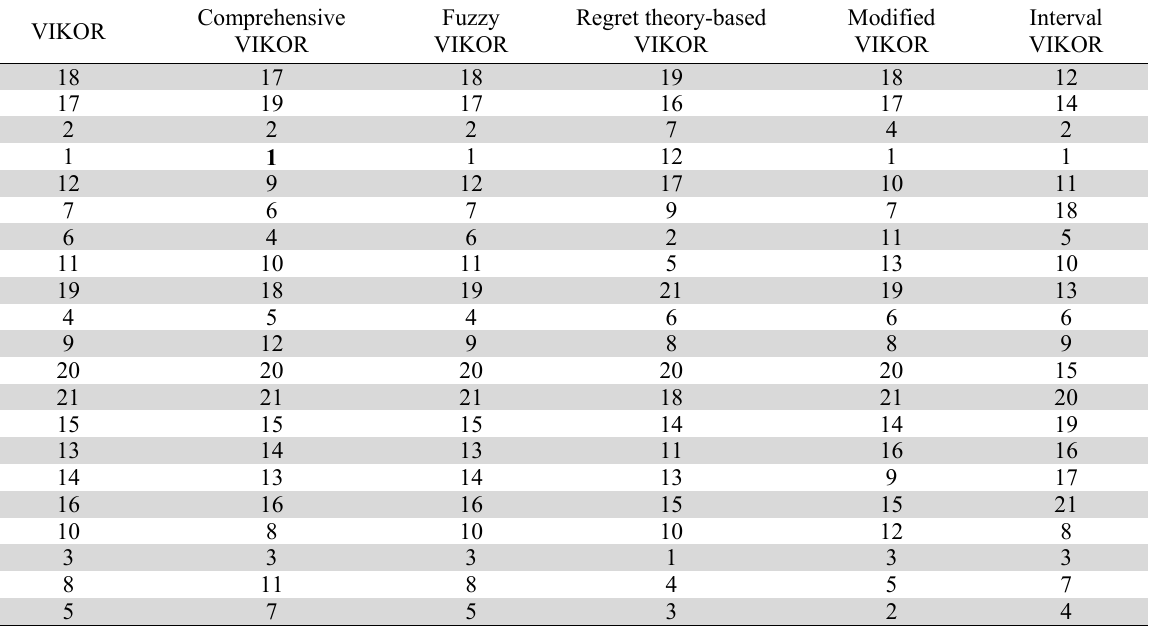
Rankings of CNC machine tools using VIKOR method and its